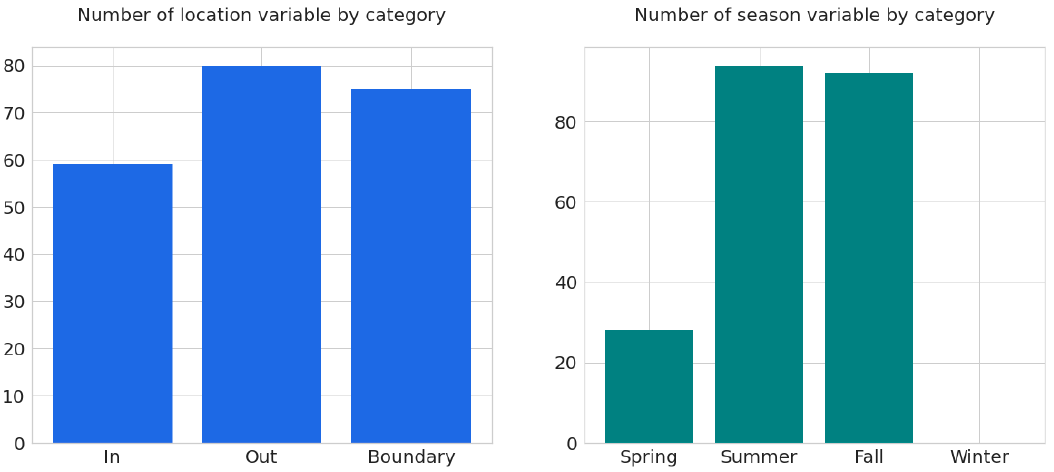
Figure 5. Number of counts for location and season.